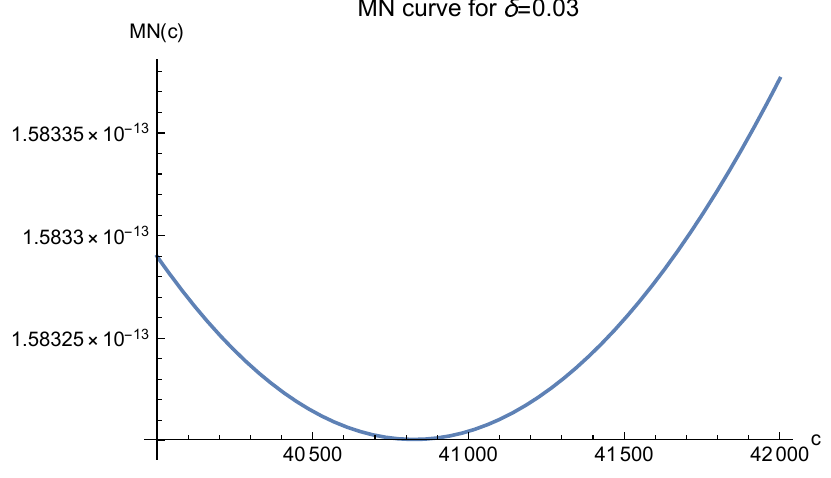
Figure 24. MN curve for δ = 0.03 where d = 3, β = 1, b 0 =